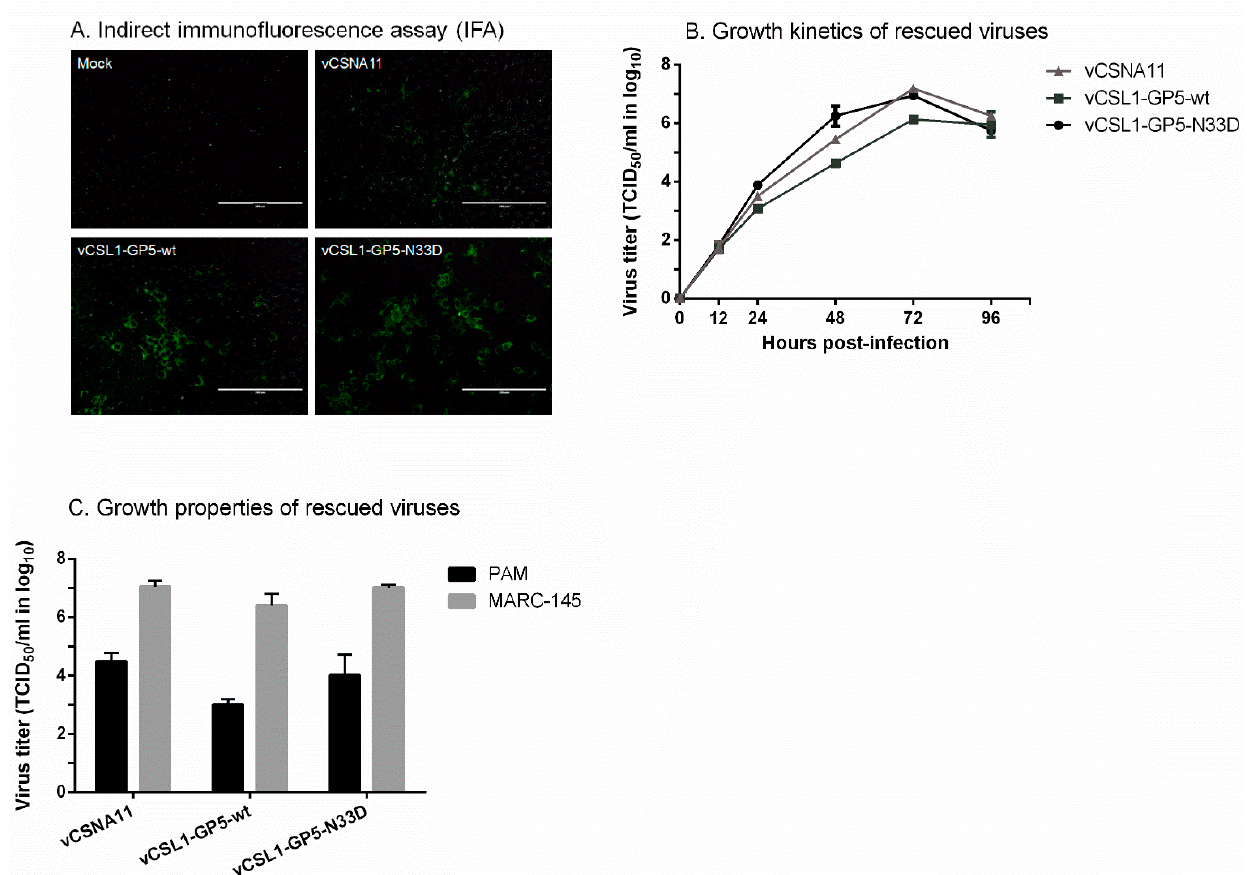
Figure 2. Characterization of mutant viruses. The in vitro growth characteristics were compared among vCSNA11, vCSL1-GP5-wt, and vCSL1-GP5-N33D. ( A ) Indirect immunofluorescence assay (IFA) was performed in MARC-145 cells to confirm the rescue of viruses. Bar, 200 µ m. ( B ) The MARC-145 cells were infected at an MOI of 0.1 to compare the growth kinetics of rescued viruses. ( C ) Growth properties of rescued viruses were compared by titration in MARC-145 cells and PAMs. Table 1. Results of the animal experiment: body weight and serum virus neutralization (SVN) antibody titer of the two groups at 8 weeks post-vaccination (wpv). The proportion of pigs showing body weight of <25 kg or ≥ 25 kg and pigs with an SVN antibody titer of <5 (log 2 ) or ≥ 5 (log 2 ) of the vaccinated group (group A, Vac) and negative control (group B, NC) at 8 wpv. Group Two-Tailed p Value A (Vac) B (NC) Body weight at 8 wpv <25 kg 1/10 3/5 0.077 ≥ 25 kg 9/10 2/5 SVN antibody titer at 8 wpv <5 (log 2 ) 4/10 5/5 0.044 ≥ 5 (log 2 ) 6/10